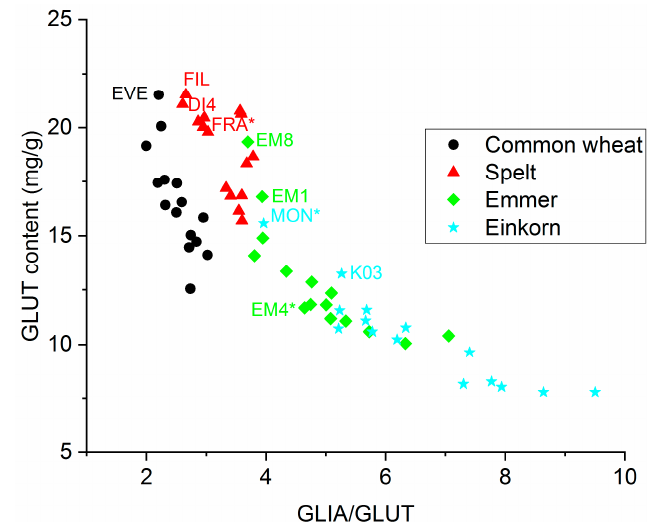
Figure 5. Scatter plot of glutenin (GLUT) content versus ratio between gliadins and glutenins (GLIA / GLUT) to identify cultivars with good predicted baking performance. The cultivars marked with an asterisk had already been identified as cultivars with good baking performance in our previous study [11]. Only samples with good predicted baking performance are labeled with abbreviations for better visibility. Abbreviations of cultivars are given in Table S1.